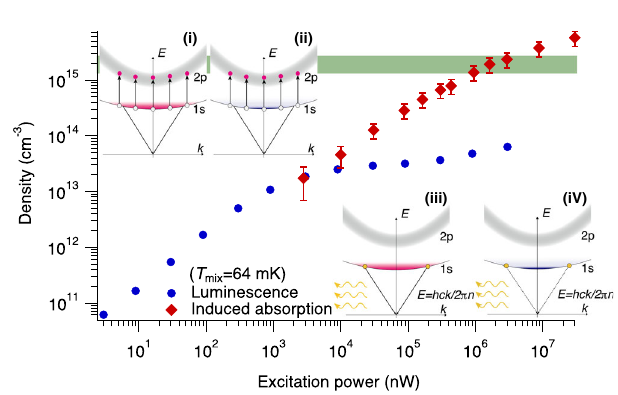
Fig. 3 | Density of trapped 1 s paraexcitons as a function of excitation power. Red diamonds show absolute densities of 1 s paraexcitons measured by induced absorption at various excitation powers when T mix is 64mK. Blue circles show densities of 1 s paraexcitons estimated solely from the luminescence intensity at variousexcitationpowers.Theredbarsshowtheaccuracyofmeasuringthedensity of 1 s paraexcitons (see Supplementary Note 5). The green shaded bar shows the BEC transition density of 1.7±0.6×10 15 cm − 3 at the measured paraexciton tem- perature of 170±30mK, where the paraexciton mass is 2.61±0.04 m 0 (ref. 40) (2.4±0.3 m 0 (ref.41)). i , ii Schematicillustration of the induced absorption process associatedwiththetransitionofparaexcitonsfromthe1 s state(whitecircles)tothe 2 p state (red circles). The transition of 1 s paraexcitons with any energy and momentumisresonantwithprobelightbecausethelinewidthofthe2 p state(grey region) is largeat1.2meV. iii , iv Schematic illustration of the directrecombination process of 1 s paraexcitons (yellow circles) with emission of photons (yellow arrows). i , iii Thestatisticaldistributionof1 s paraexcitonsconsistsofnon-quantum degenerate states at a low density. ii , iv The statistical distribution of 1 s para- excitons contains quantum degenerate states at a high density.